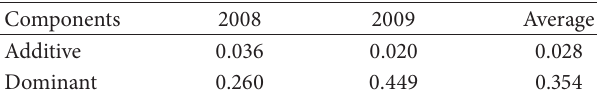
Table 6: Genotypic variance components for sugar content. Table 7: Proportional contribution (%) of the lines, pollinators, and interactions to the expression of sugar